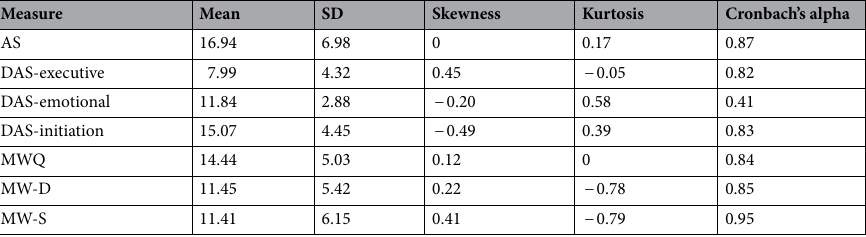
Table 1. Descriptive information of study 1 (N = 587). AS apathy scale, DAS dimensional apathy scale, MWQ mind wandering questionnaire, MW-D deliberate mind wandering scale, MW-S spontaneous mind wandering scale, SD standard deviation.